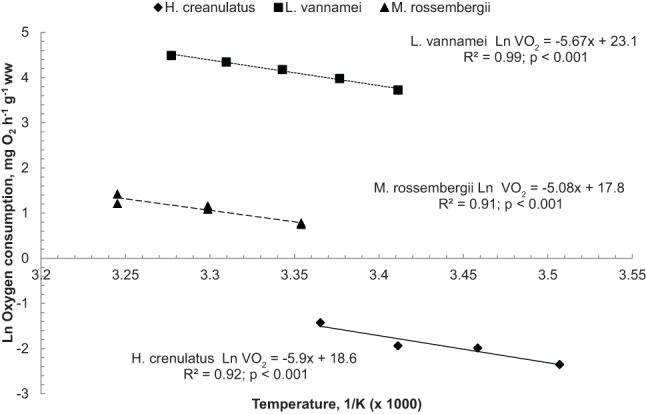
Effect of temperature on oxygen consumption in tropical and sub-polar–temperate crustaceans. An Arrhenius plot of temperature vs oxygen consumption reveals that energy required to activate the enzyme complex (Ei) involved in respiratory metabolism is higher in tropical (L. vannamei,
González et al., 2010; M. rosenbergii,
Manush et al., 2004) than in sub-polar–temperate (H. crenulatus, this study) species.